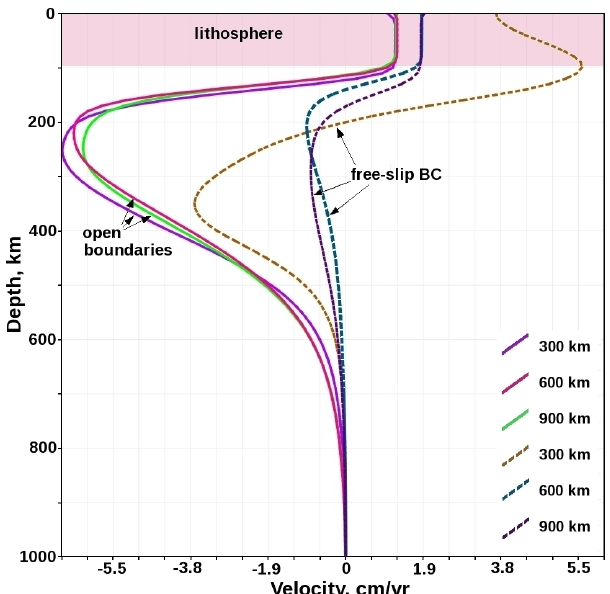
Fig. 6. Velocity profiles for the model with open boundaries, OO6 (solid lines) and model with closed boundaries, CRCR6 (dashed lines). Profiles were taken after 14My from the beginning of the subduction process, distances from the left side of the model domain indicated in the legend.